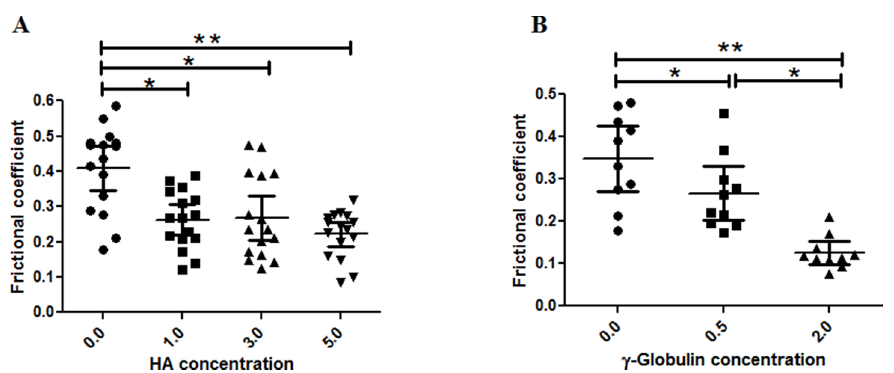
Figure 9. AFM measured frictional coefficients of advanced OA cartilage measured in a range of (A) HA (no of observation 5 16) and (B) c –globulin (no of observation 5 10) concentrations. Increased concentration of HA and c –globulin shows a decrease in frictional coefficients of advanced OA cartilage samples. The frictional coefficient values were from measurements at different locations on two samples of advanced human cartilage from a single femoral head. Vertical bars represent the 95% of confidence interval. *P , 0.01 and **P , 0.0001.